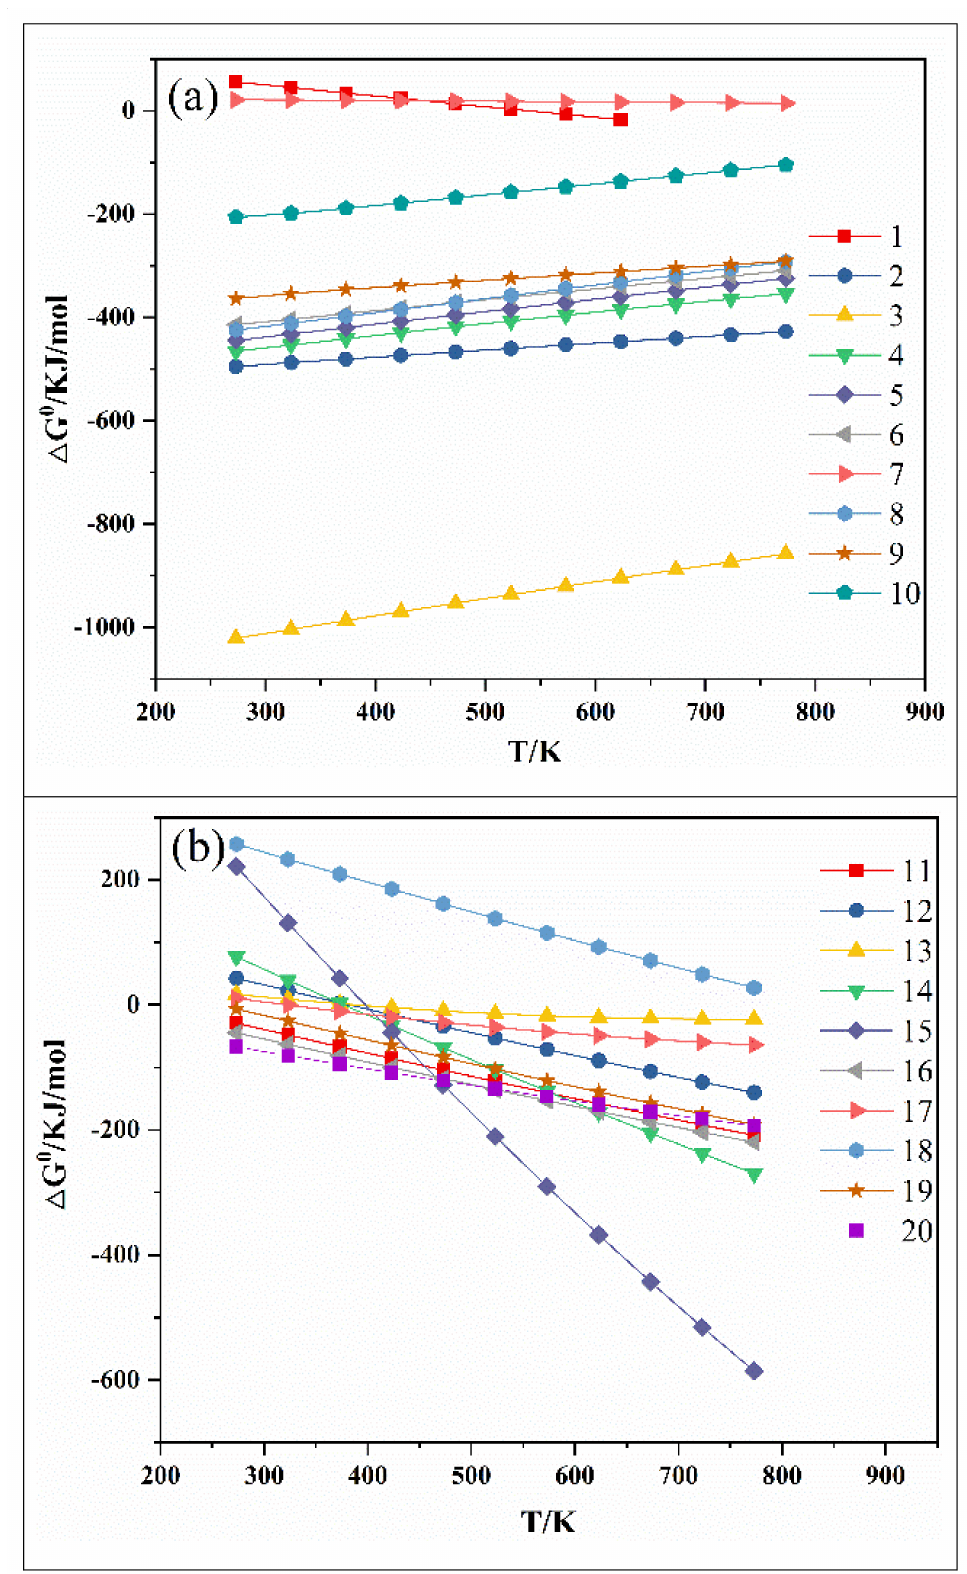
− T diagrams for potential chemical reactions between vanadium slag and ABS during Figure 2. ∆ G o T the roasting process, where ( a ) shows the reactions 1 to 10 and ( b ) shows the reactions 11 to